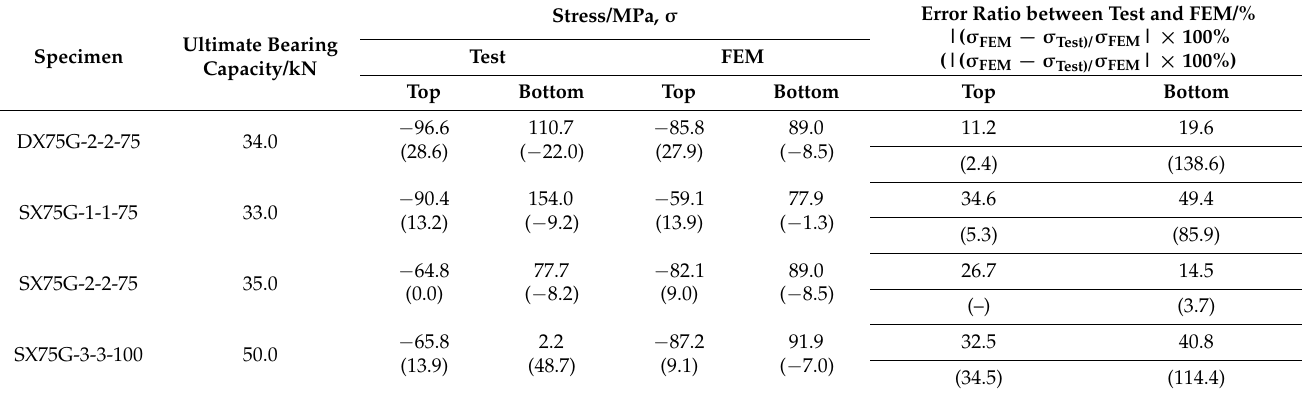
Table 7. The bilateral midspan normal stress under the ultimate bearing